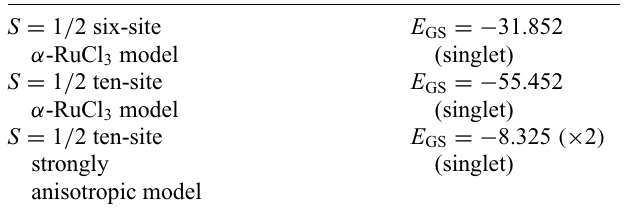
TABLE III. The ground-state energies of the Kitaev- Heisenberg